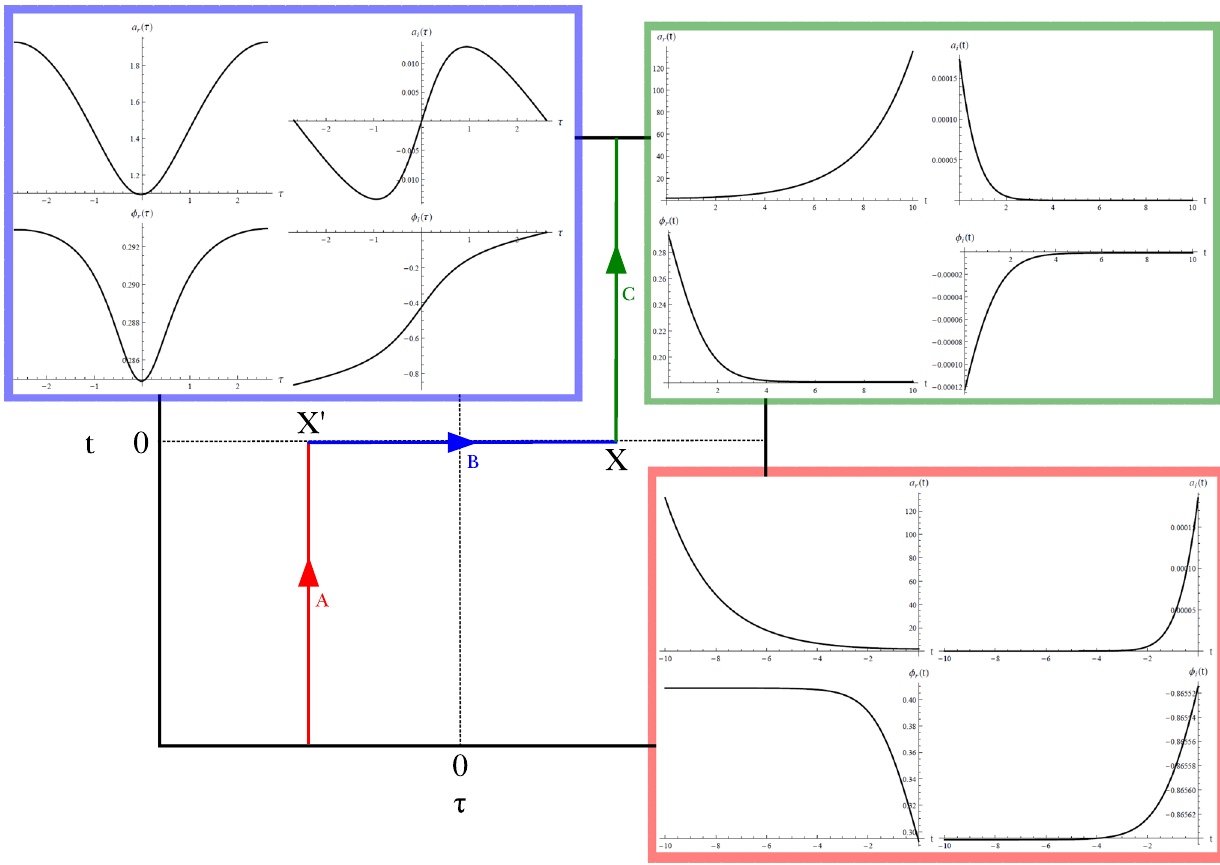
Fig. 2 Complex time contour and numerical solution of a r , a i , φ r , and φ i for V st . Now both of Part A (red) and C (green) can be classicalized